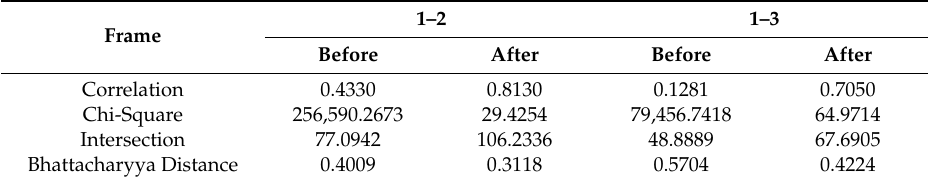
Figure 6. Histograms before and after histogram matching: ( a ) Before histogram matching; ( b ) After histogram matching. Table 2. Correlation test before and after histogram matching.